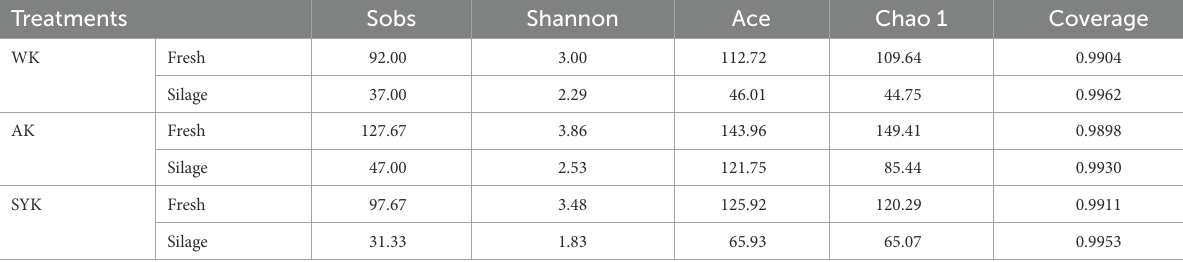
TABLE 4 Alpha diversity of the bacterial community in fresh materials and ryegrass silage. Treatments Sobs